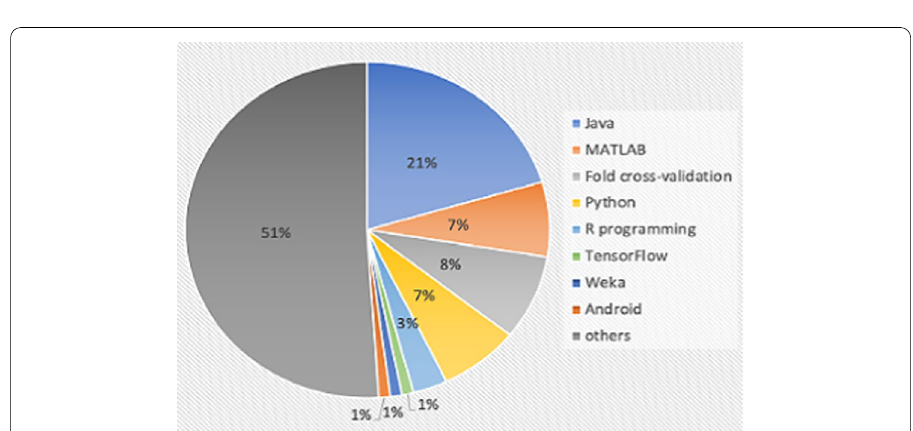
Fig. 9 Simulation platforms used for developing different recommender